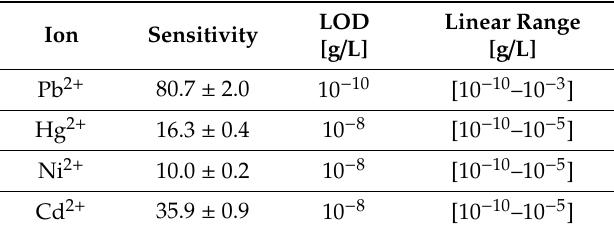
Table 3. Comparative study: responses of sensors based on polymer P1 for the different ions Pb 2+ , Hg 2+ , Ni 2+ and Cd 2+.